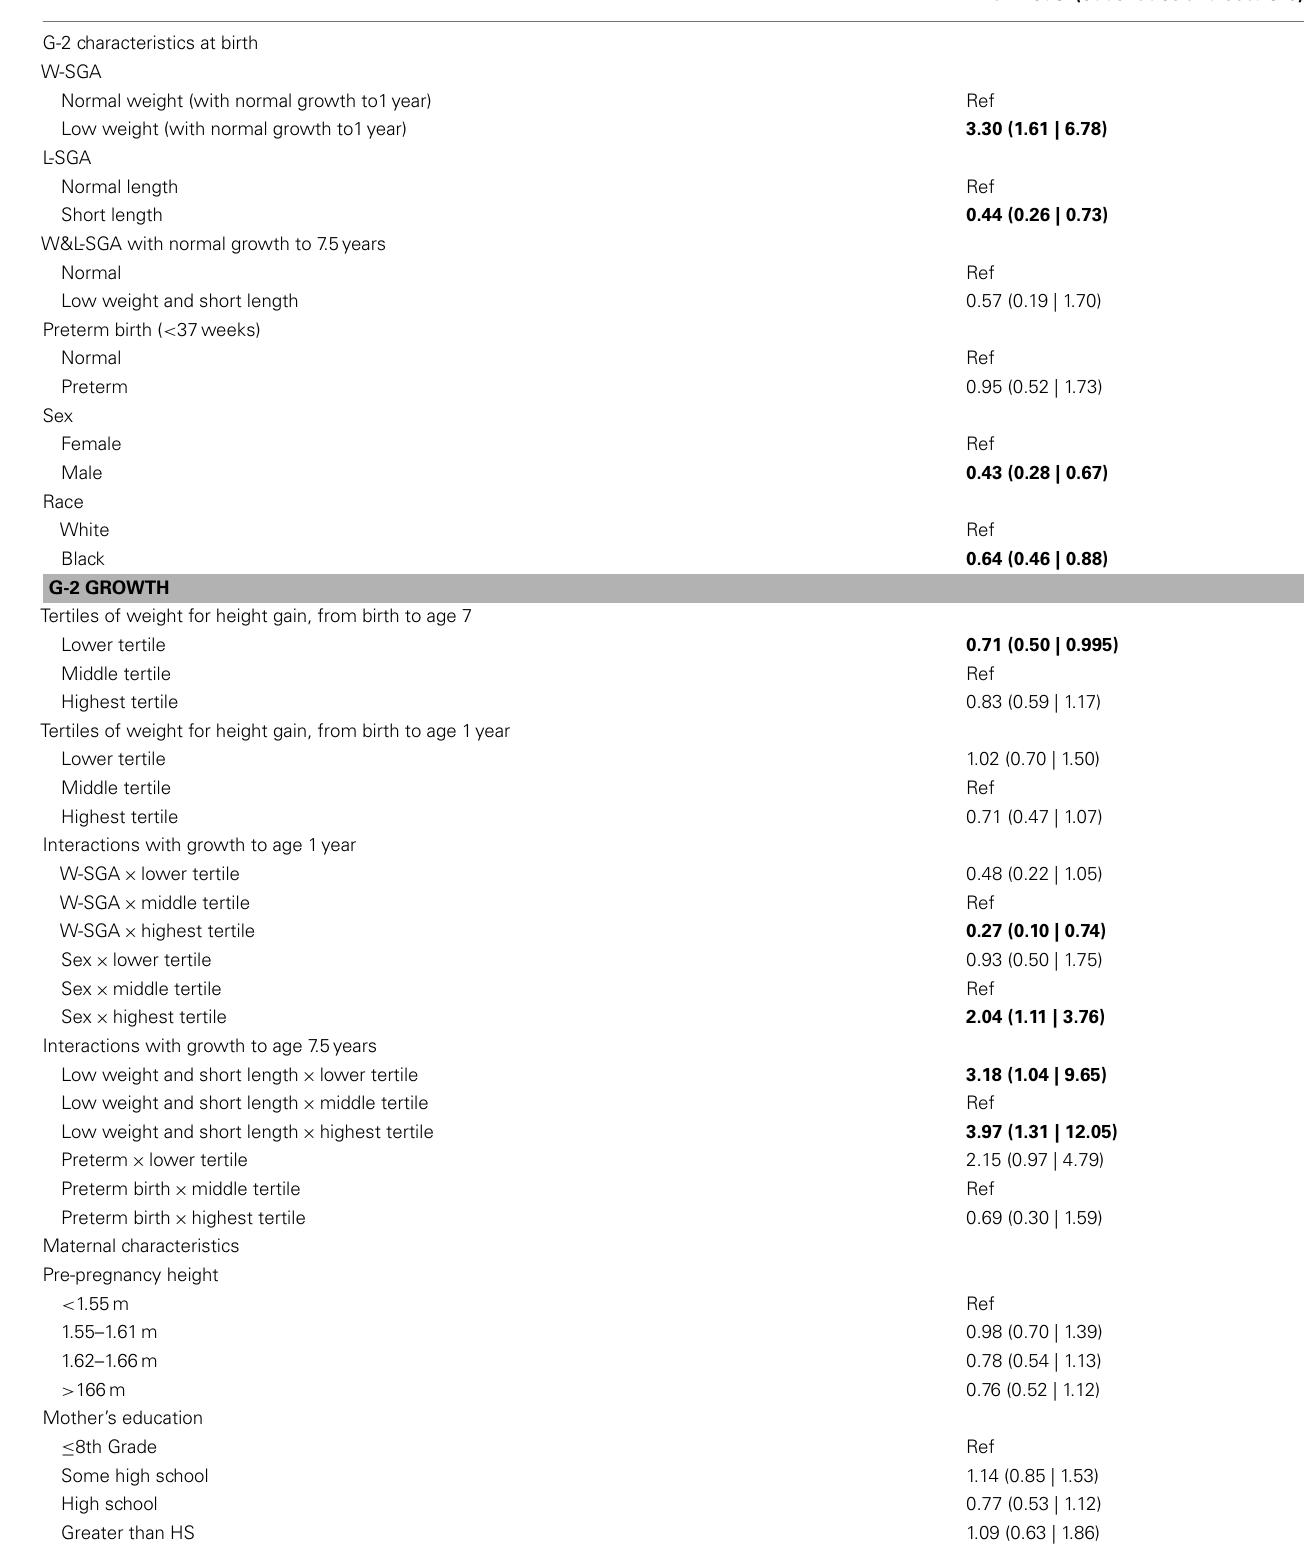
Table 2 | Final multiple logistic regression model of the relationship between early growth and later mental